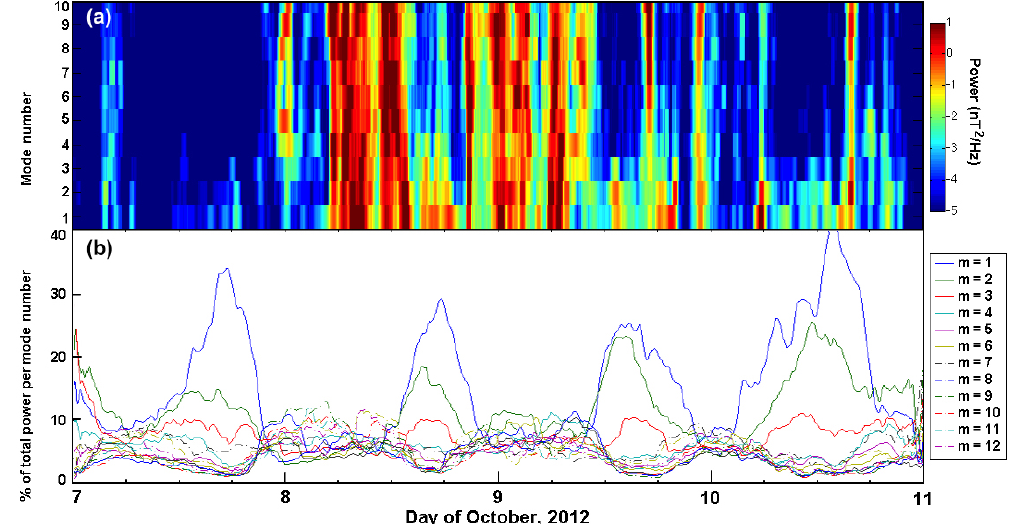
Figure 4. (a) Power per m number calculations for the first 4 days of Fig. 3, using cross-spectrogram calculations between GOES-14 and GOES-15; (b) fraction of power in one of the wavenumbers m = 1 to 12 over total power. Lower wavenumbers m = 1 to 6 are plotted with solid lines, and higher wavenumbers m = 7 to 12 are plotted with dashed–dotted